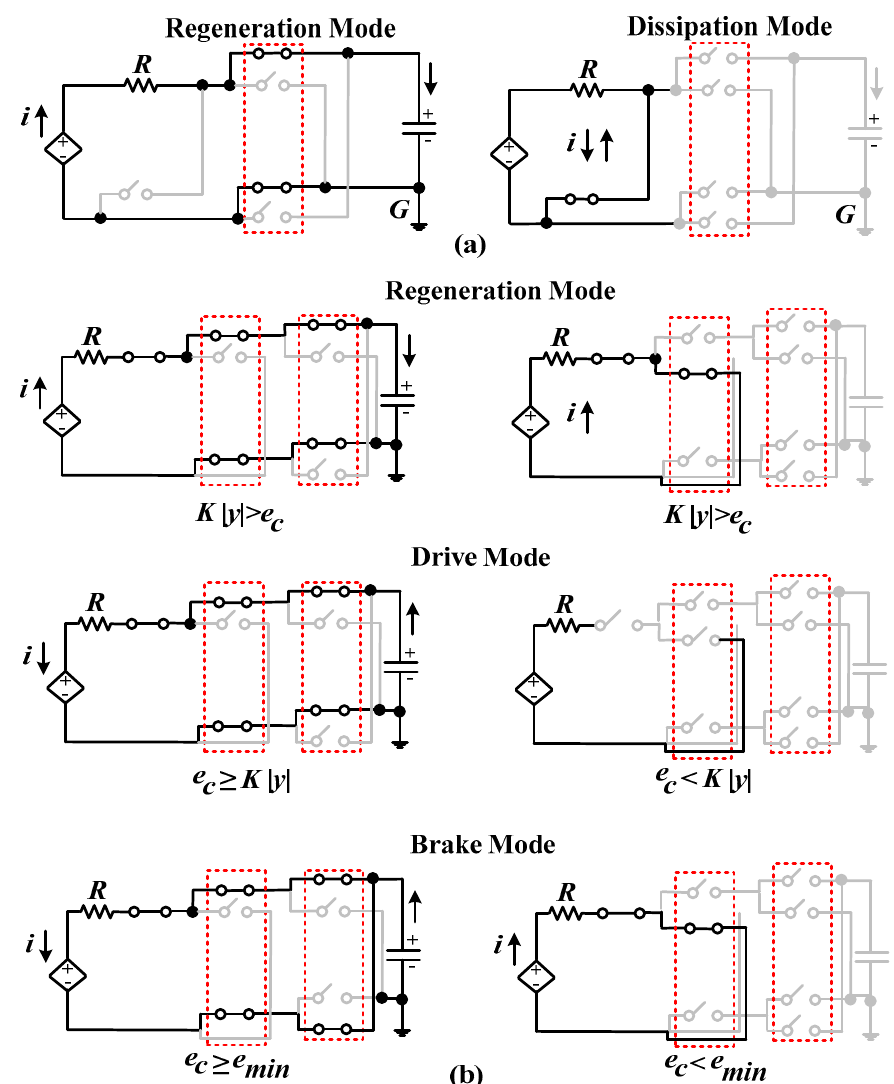
Figure 24. Operation modes and the associated electrical circuits for the ( a ) passive EMEH system; ( b ) active EMEH system [127]. Reprinted with permission from Hasheminejad, Rabiee and Markazi (2018). Copyright 2018 ASCE Library.